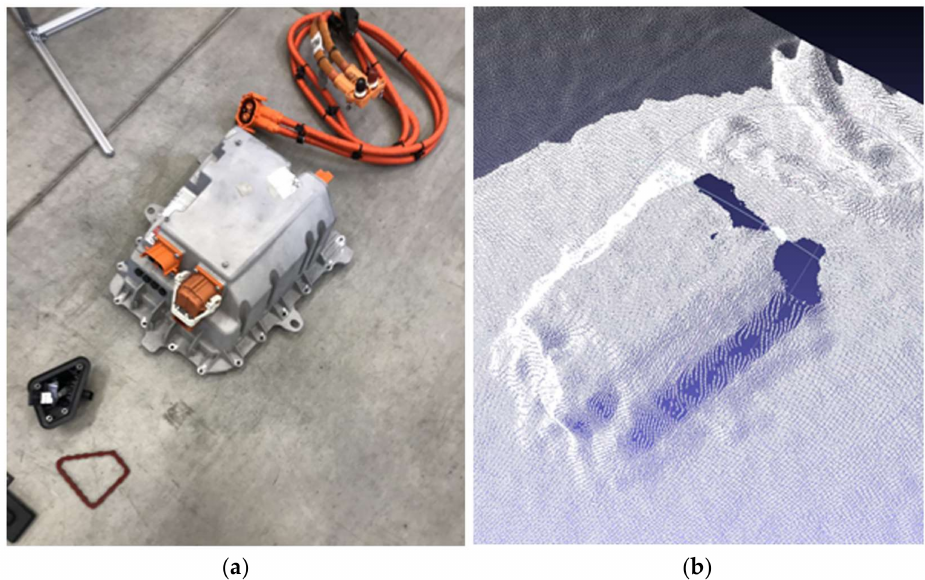
Figure 6. Picture of a switch box ( a ) and the corresponding point cloud that was produced by the Realsense D435i ( b ).